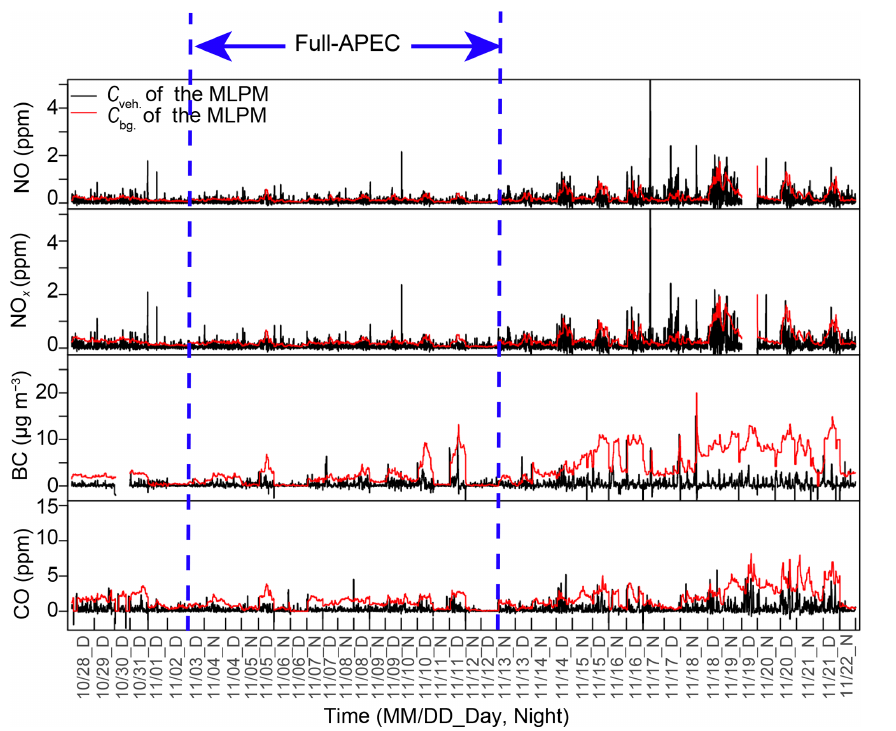
Figure 7. Time series of the separation results using the moving low-percentile method (MLPM) for NO, NO x , BC, CO, SO 2 , and O 3 . The red lines represent moving 5min fifth percentiles of the measured pollutant concentrations to determine on-road background concentrations. The black lines represent estimated on-road emission concentrations, which were obtained by subtracting the background concentrations from the original